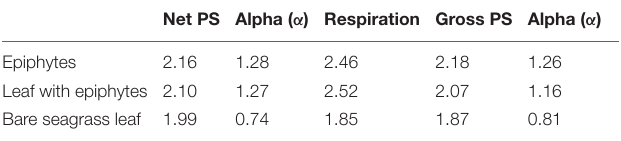
TABLE 1 | Q 10 values for photosynthetic parameters: dark respiration, maximum net and gross photosynthesis, and their respective light use efficiencies ( α ), of Z. marina L. leaves with and without epiphytes, and for epiphytes originating from Z. marina leaves.